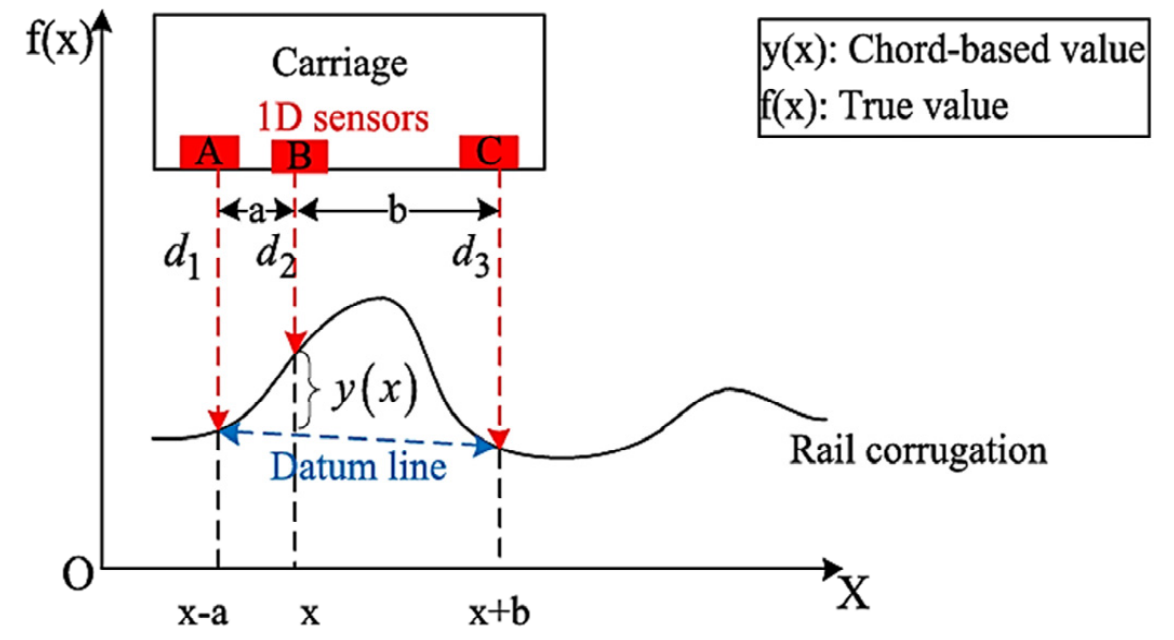
Figure 1. Measurement principle of the rail surface signal [21].